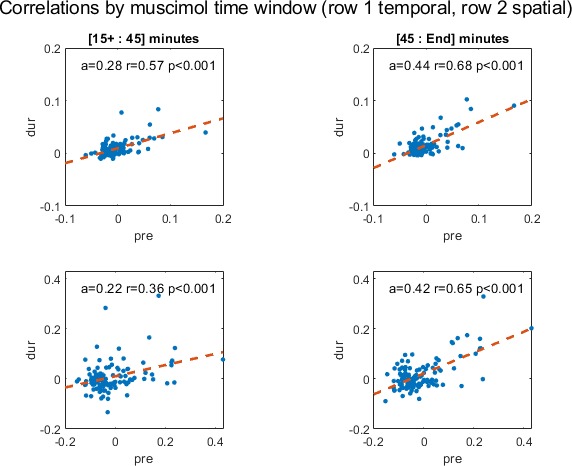
Temporal correlations pre-inactivation plotted against the recording period during inactivation used in this analysis for cell pairs in cohort; all recordings after muscimol injections are from 15 to 45 minutes (top left) and all remaining recordings are from 45 minutes (top right) of the muscimol recording session.Slope of the regression line (a), correlation coefficient (r) and p-value (p) are shown. The second row depicts the same plots for spatial correlations. Because recordings had different starting and ending times, [15+, end] are used to signify the start and end of the recording time; on average, recordings started 16 minutes after and ended 115 minutes after muscimol injection into the hippocampus.